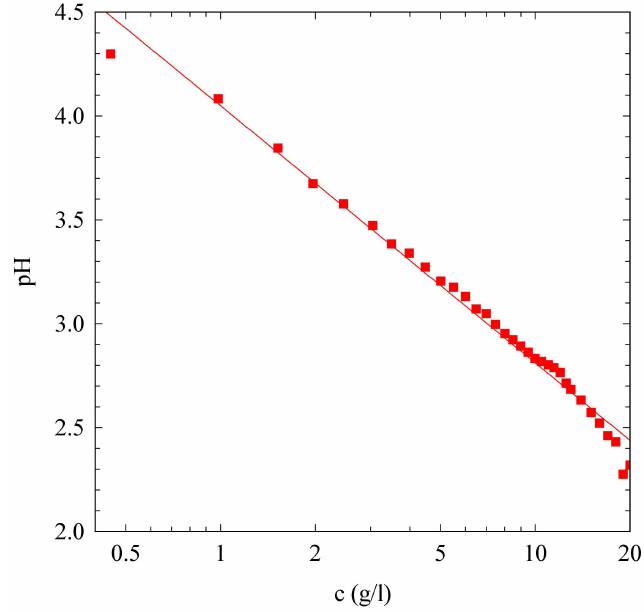
Figure 1. Dependence of the solution pH on the SAP concentration (log scale). The continuous line is a logarithmic fit, pH = − 1.24log ( 5.36 × 10 − 4 c )